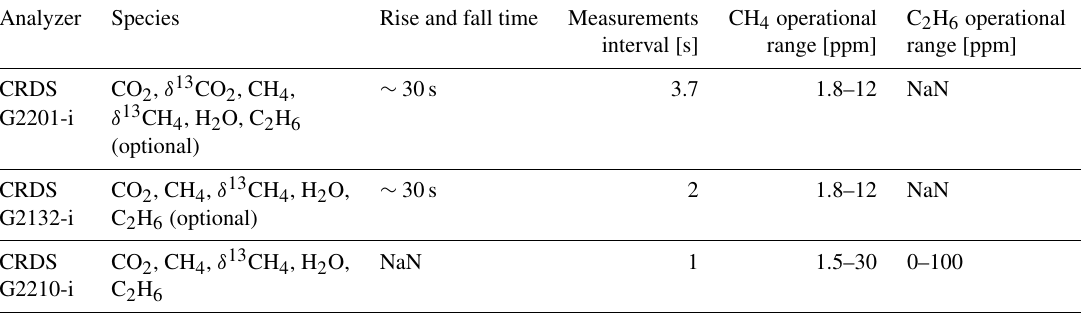
Table 1. Characteristics of the instruments used during the study. NaN – data are not available in the data sheet provided by Picarro Inc. Analyzer Species Rise and fall time